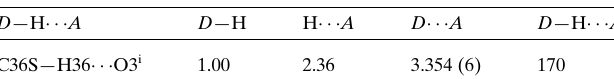
Table 2 Hydrogen-bond geometry (A˚ , (cid:2) ).